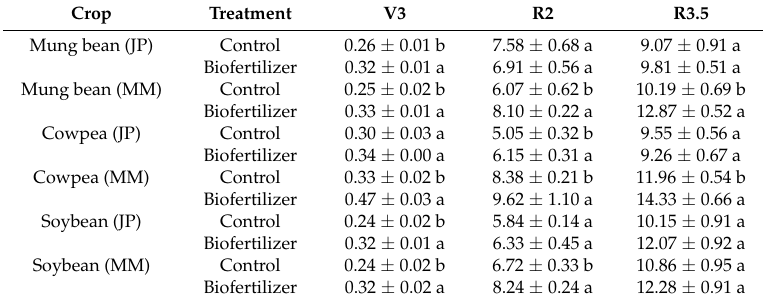
Table 9. Effect of biofertilizer on K uptake (mg pot − 1 ) of mung beans, cowpeas and soybeans at different growth stage.